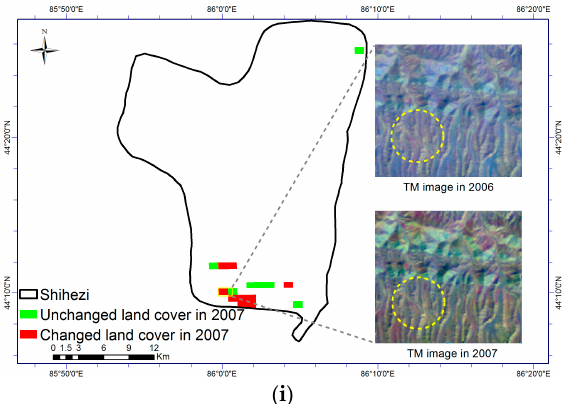
Figure 8. Mixed expansion patterns and accuracy assessments for selected metropolitans: ( a ) Hefei from 1993 to 2013; ( b ) Map of Hefei in 1998; ( c ) Accuracy assessment of expansion where residency areas were densified; ( d ) Qiqihar from 1993 to 2013; ( e ) Map of Qiqihar in 1995; ( f ) Accuracy assessment of expansion where both roads or houses were identified; ( g ) Shihezi from 1993 to 2013; ( h ) Map of Shihezi in 2007; ( i ) Accuracy assessment of expansion where a road appeared.